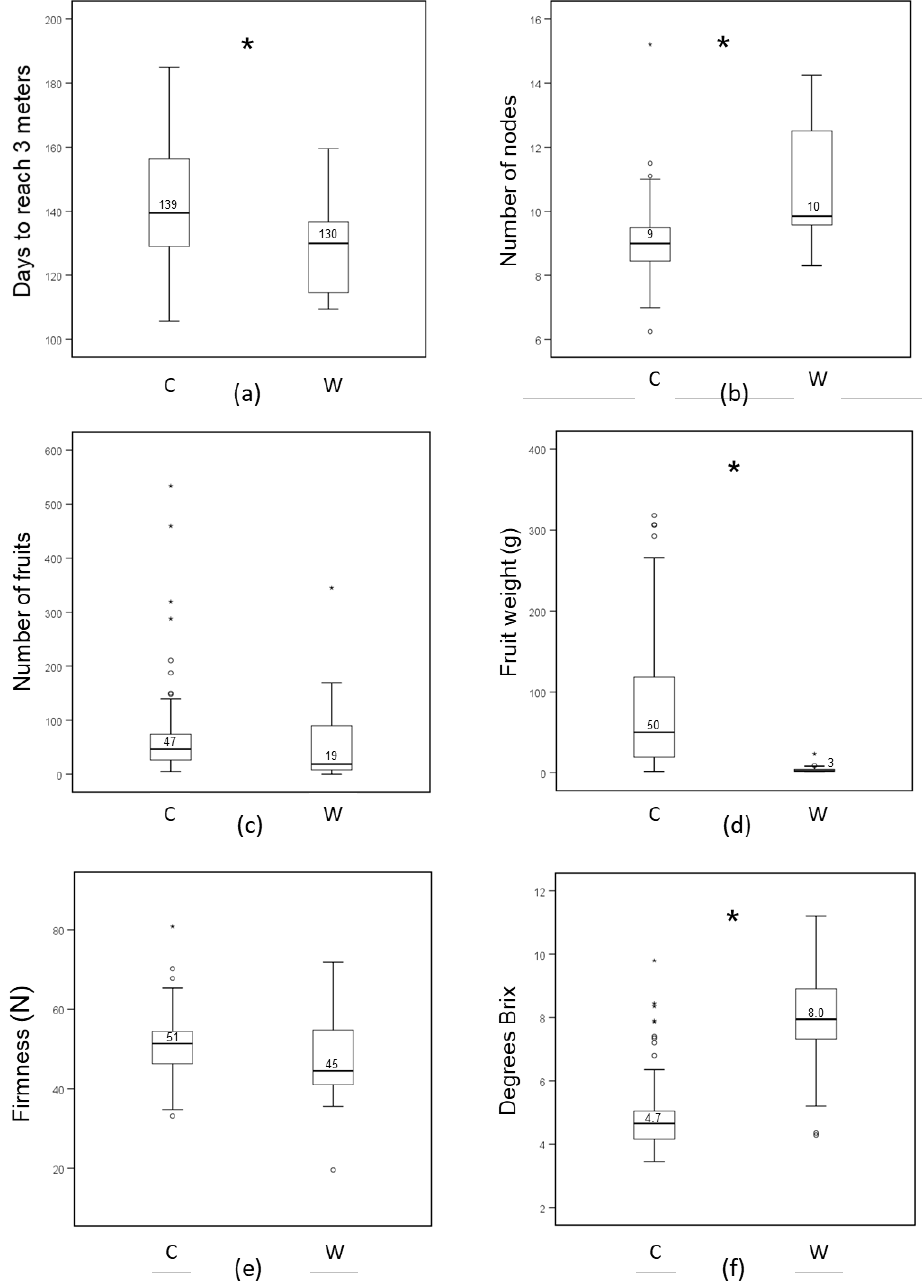
Figure 4. Distribution of fruit yield and fruit quality-related traits among the core collection based on the two classes of genotypes, cultivated (C) and wild (W). ( a ) Plant growth speed; ( b ) Time to flowering; ( c ) Fruit number; ( d ) Fruit weight; ( e ) Fruit firmness; and, ( f ) Degrees Brix. Traits marked with * show a significant difference (T-test, p < 0.05) between cultivated and wild accessions. Numbers in the plots represent the median value. Outliers are marked with an open circle and far outliers with an asterisk, according to SPSS criteria.